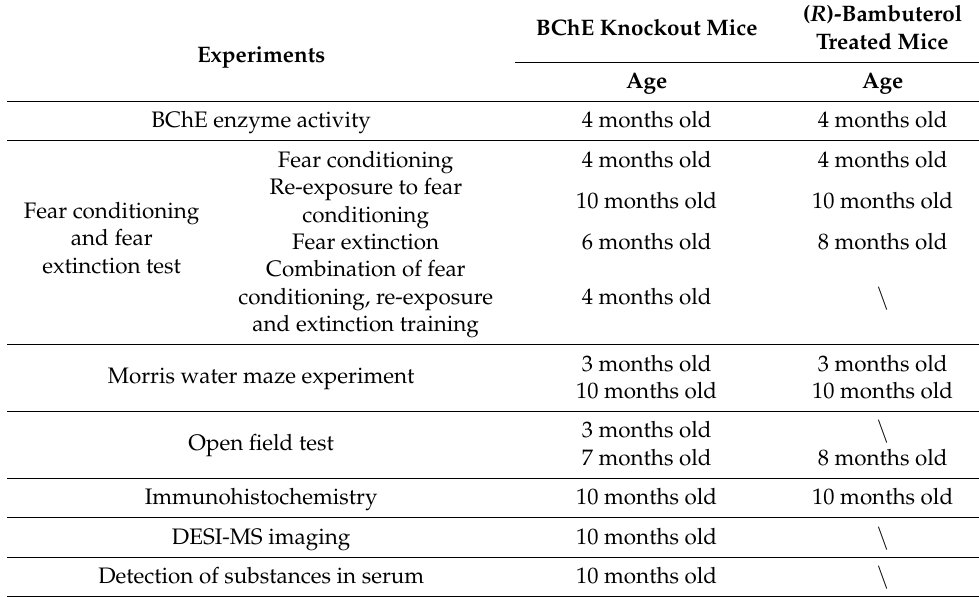
Table 2. Summary of the mice at different ages for each